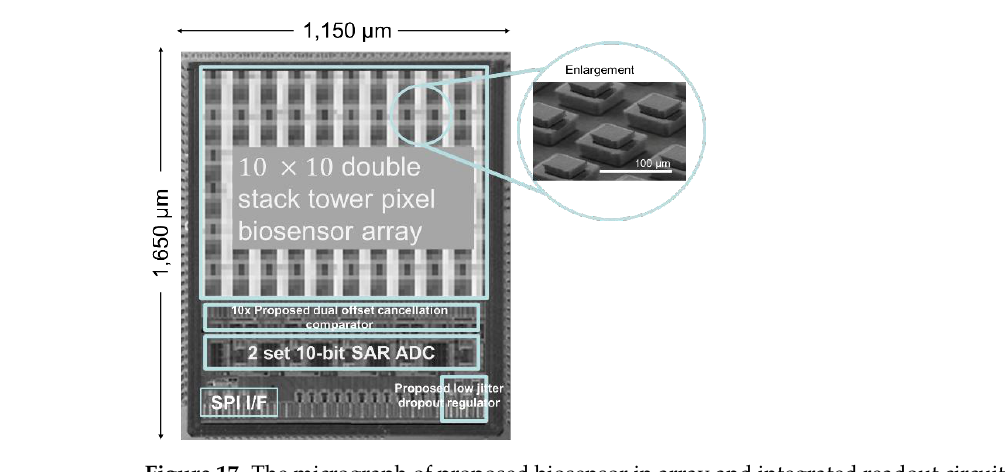
Figure 17. The micrograph of proposed biosensor in array and integrated readout circuit on the same silicon substrate. The 3D MEMS-based double stacked tower biosensor is shown.